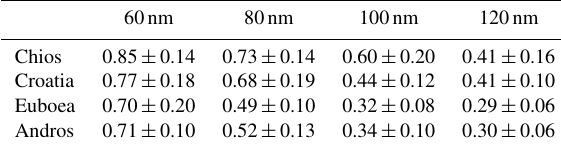
Table 1. Calculated chemical dispersion in terms of σ(κ)/κ for the four studied fire events and all measured particle